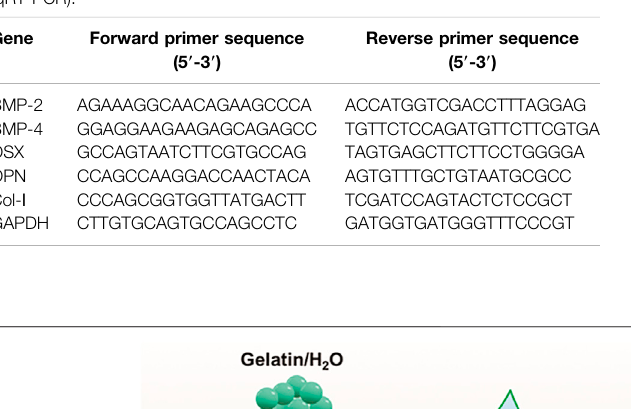
Frontiers in Bioengineering and Biotechnology |